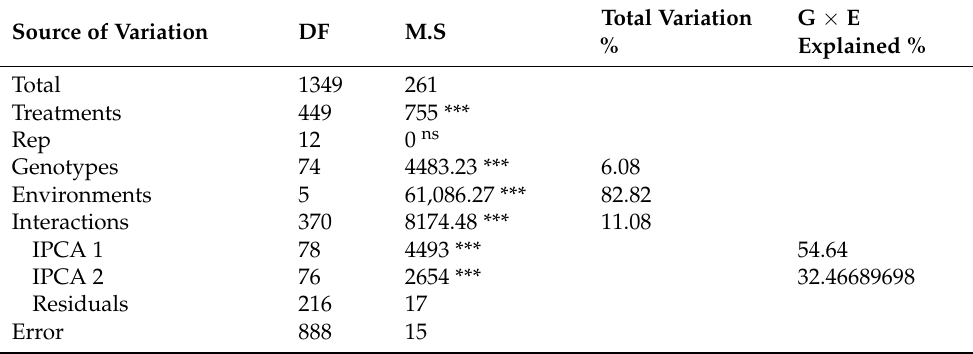
Table 2. Additive main effects and multiplicative interaction analysis of variance for dry matter yield of 75 QPM genotypes tested across six